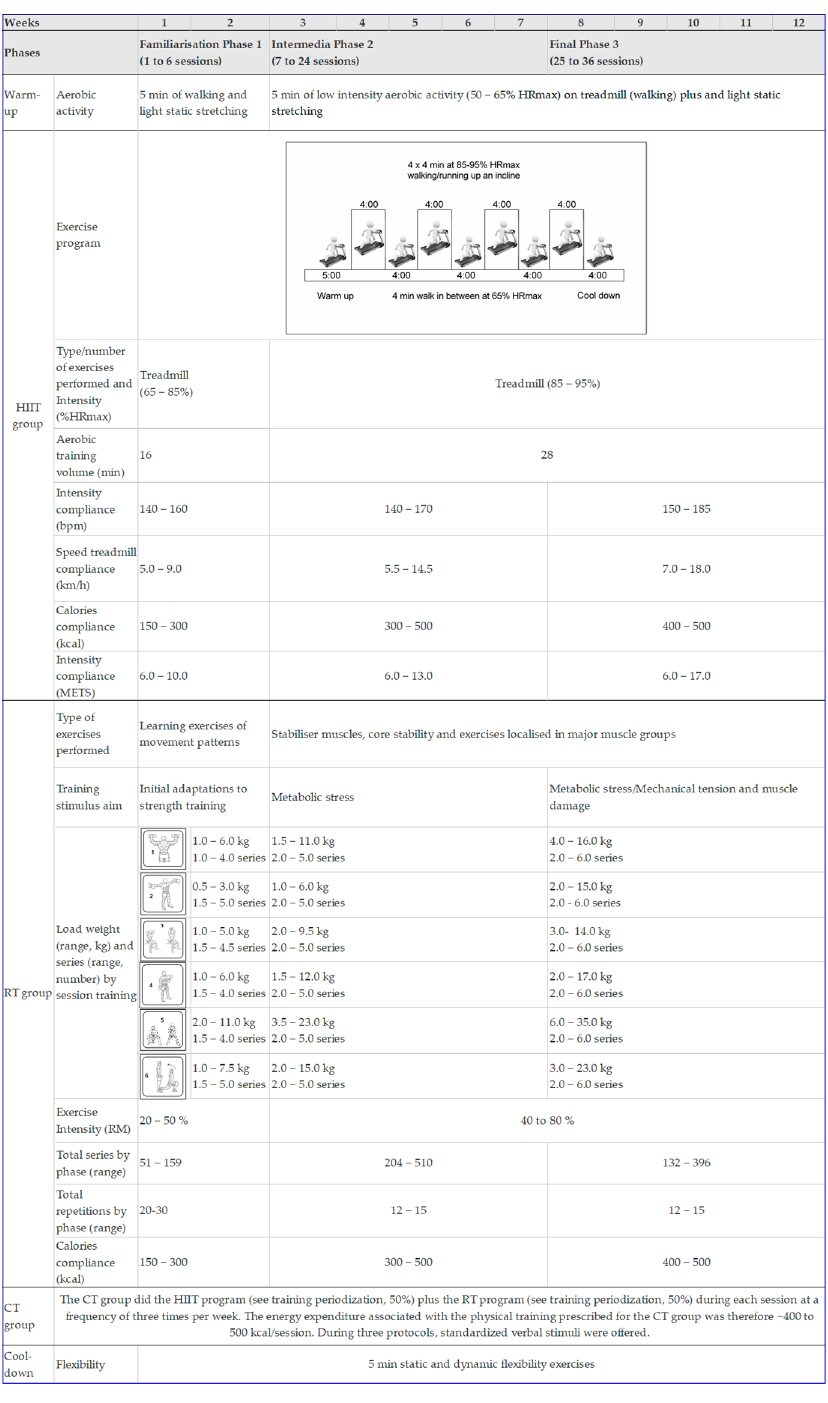
Figure 1. Training periodization of the study (ClinicalTrials.gov ID: NCT02715063). HIIT: high-intensity interval training group; RT: resistance training group; CT: combined training (HIIT + RT) group. HR: heart rate; RM: repetition maximum. Bpm: beats per min (heart rate). To RT group, external load was adjusted weekly to maintain the % of the 1RM (from 40% to 80% of 1RM) and total number of repetitions per exercise (12 to 15 repetitions). The intensity of the exercises increased individually and progressively according to the participants’ response on each day of exercise. The caloric cost of exercise session was calculated based on the one metabolic equivalent (MET) criteria, defined as the amount of oxygen consumed while sitting at rest with a value of 3.5mL O 2 per kg body weight × min. Additionally, assistance was provided to subjects during the exercise to complete the proposed